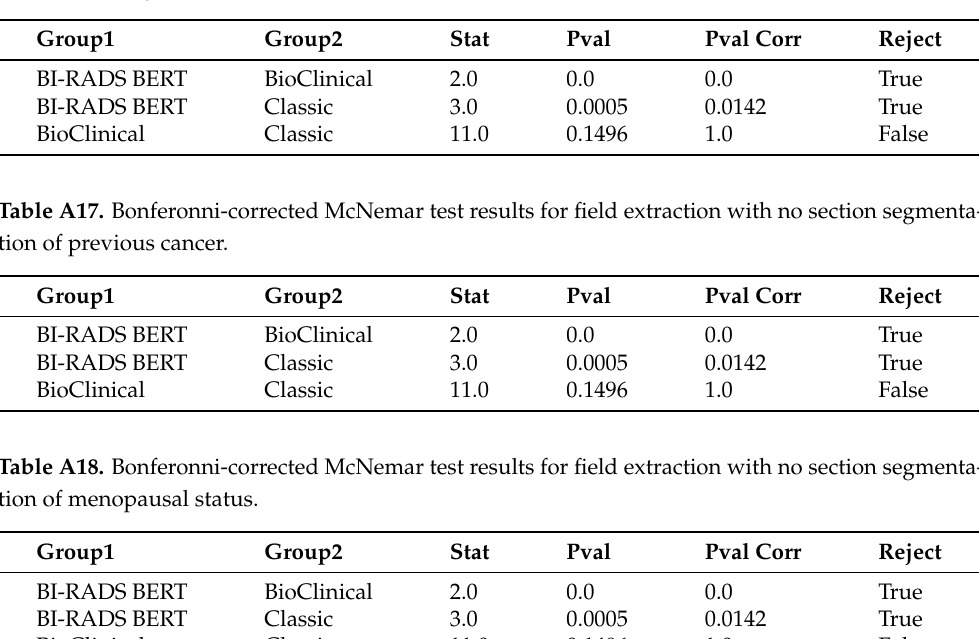
Table A16. Bonferonni-corrected McNemar test results for field extraction with no section segmenta- tion of modality.